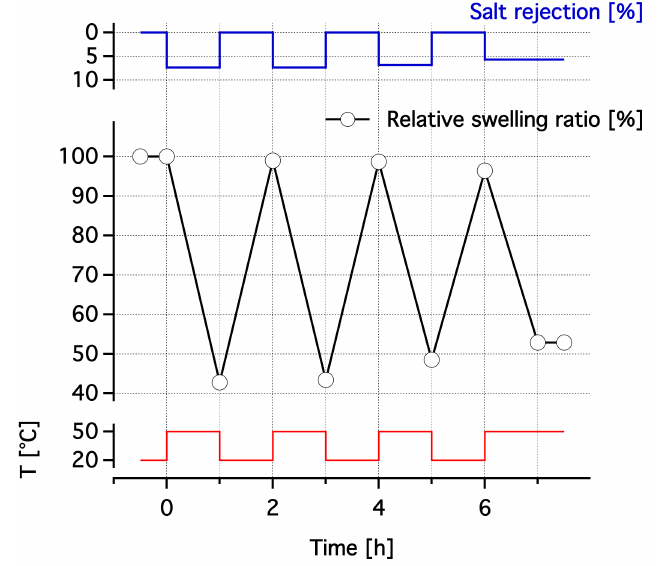
Figure 18. Swelling/dewatering cycles of GG10K–20 gel (powder form) in response to temperature changes for 2 h cycles between 20 and 50 ◦ C in brine solution of 2 gL − 1 NaCl, and the corresponding salt rejection for each